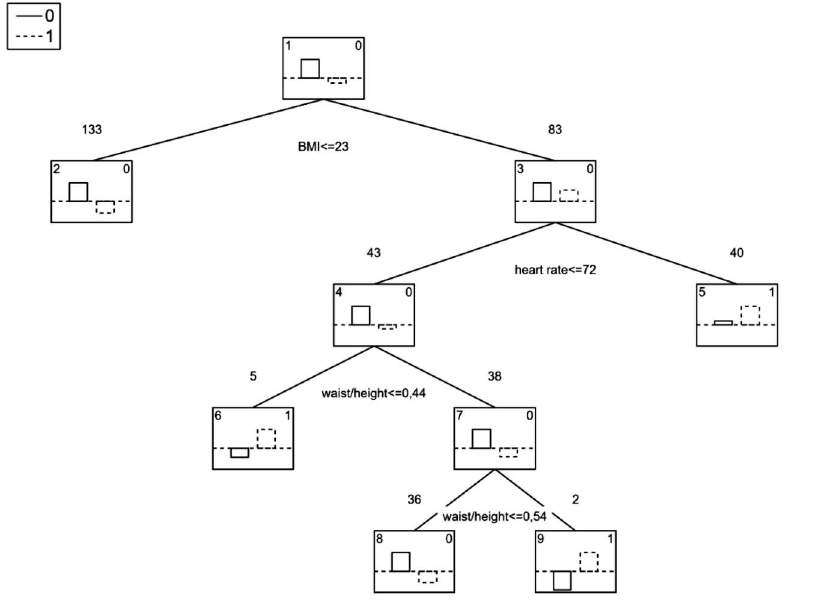
Figure 2. The classification tree for